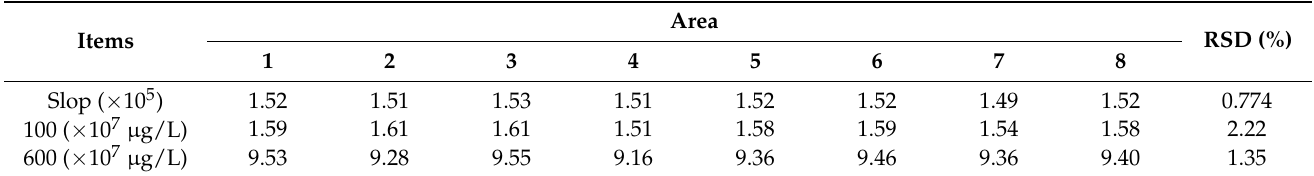
Table 3. Slopes of standard curves and the signal value of H 2 O 2 standard solution measured in HRP method on different days.